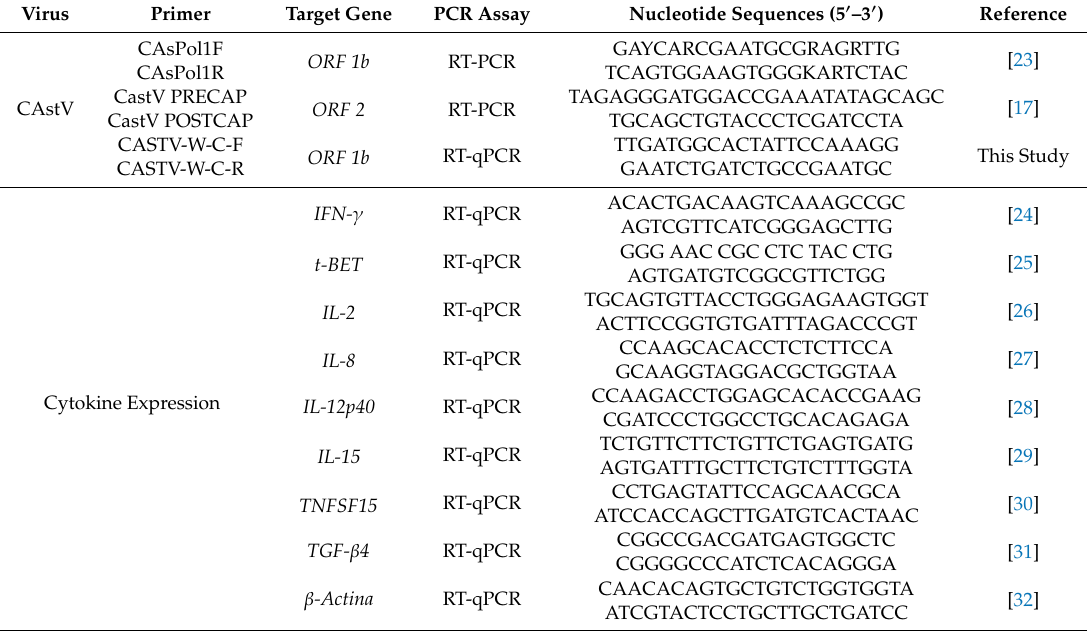
Table 1. Sequences of primers used in the molecular assays for the detection and quantification of chicken astrovirus (CAstV) and the relative gene expression of cytokines in the spleen, jejunum, liver, and thymus of chicks naturally a ff ected with white chick